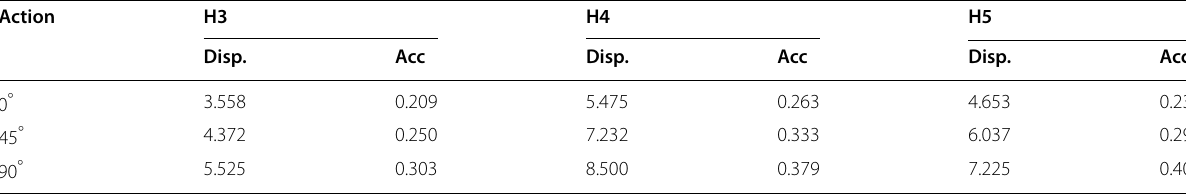
Table 4 Peak relative displacement and peak acceleration.